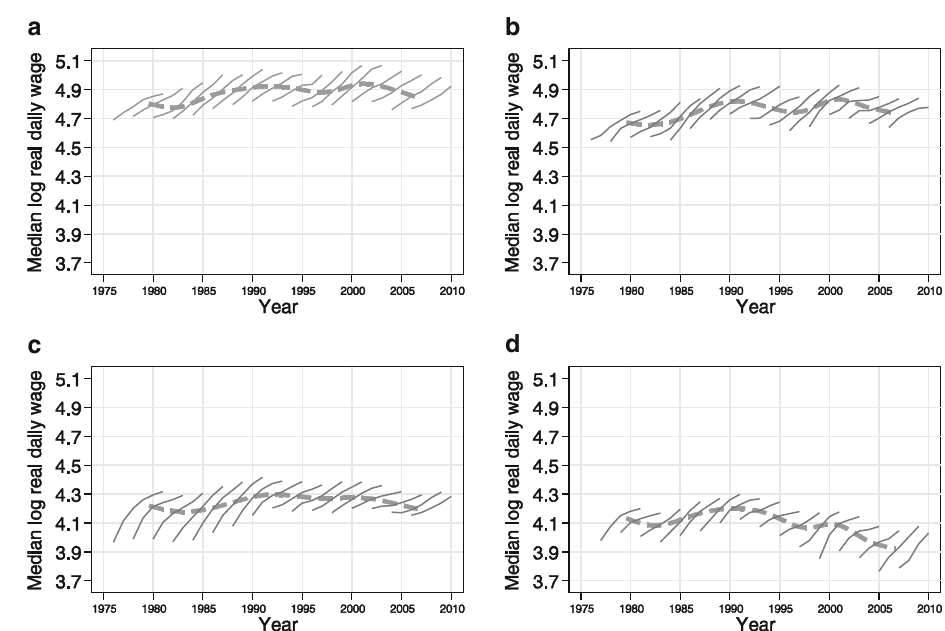
Fig. 5 Median Log Real Daily Wage Profiles for Labor Market Entrants (Potential Experience) (Source: 2% IABS Sample for full-time workers with less than five years of potential experi- ence and a positive log real daily wage. N = 1,703,254. Note: Displayed are log real median wage by potential experience for two-year-cohorts ( solid lines ). Dashed lines denote the me- dian wage for each cohort from 1976/77 to the 2006/07 cohort in the first five years of labor market entry. See Table 1 in